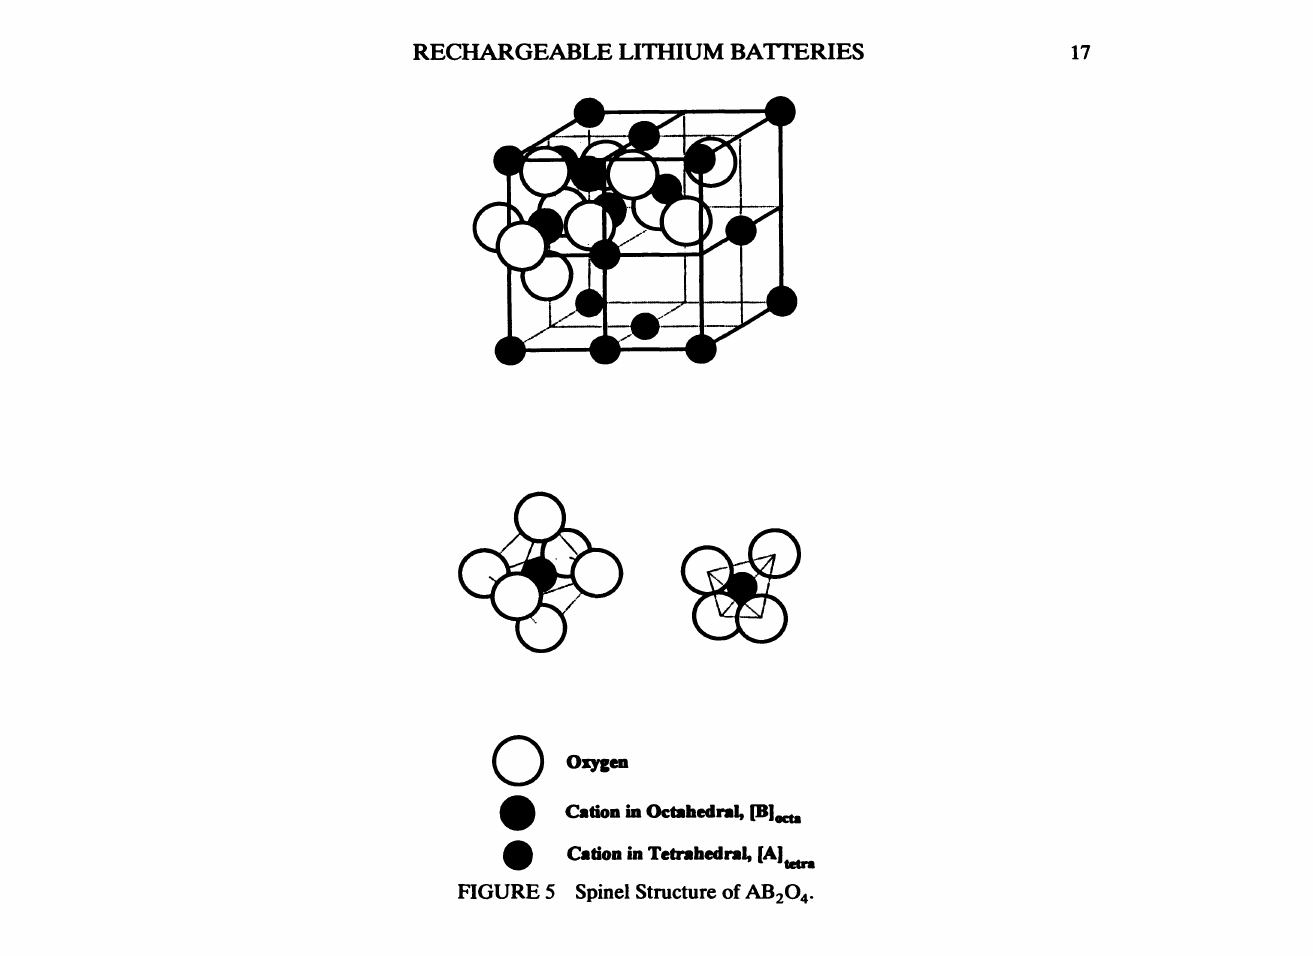
FIGURE 5 Spinel Structure of